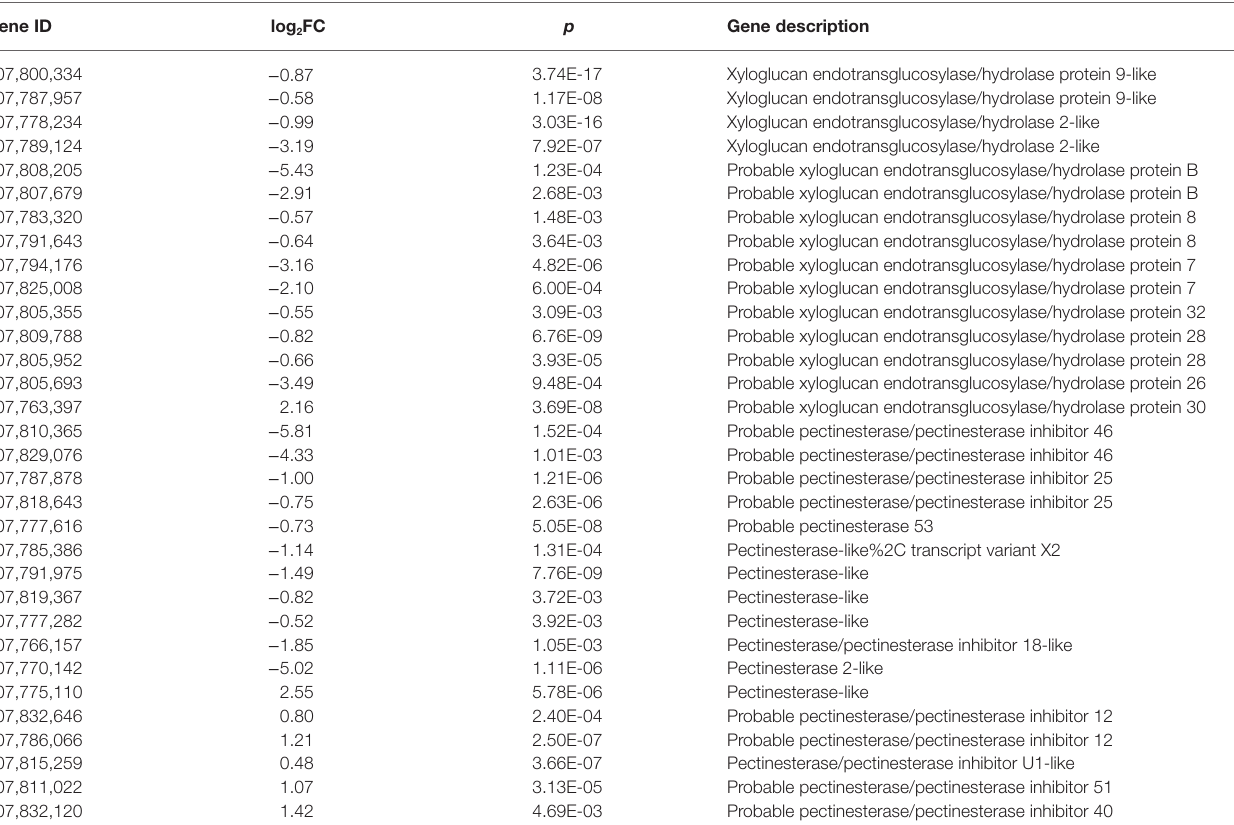
TABLE 1 | Differentially expressed genes (DEGs) related to cell wall